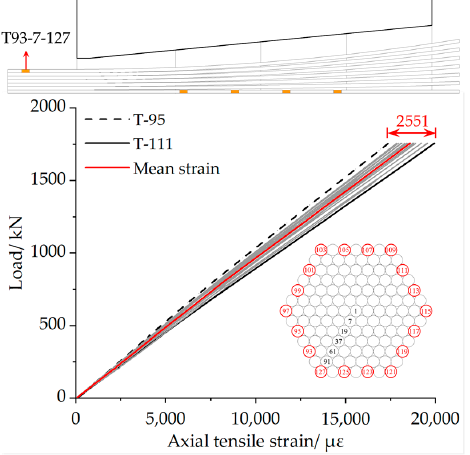
Figure 15. Axial tensile strains of the BFRP cable in the test section.